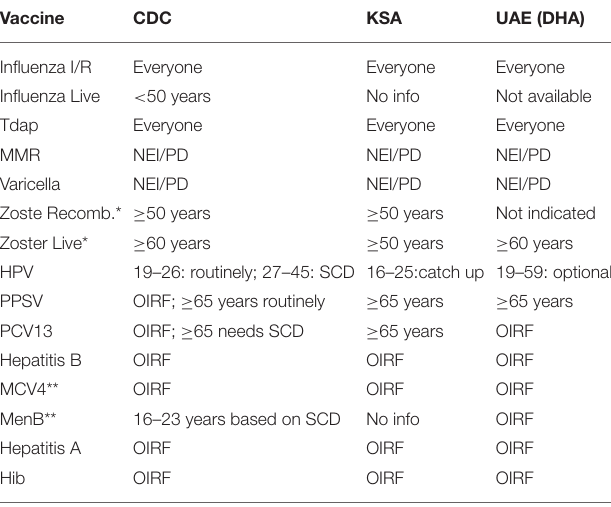
TABLE 1 | USA, KSA, and UAE adult vaccination